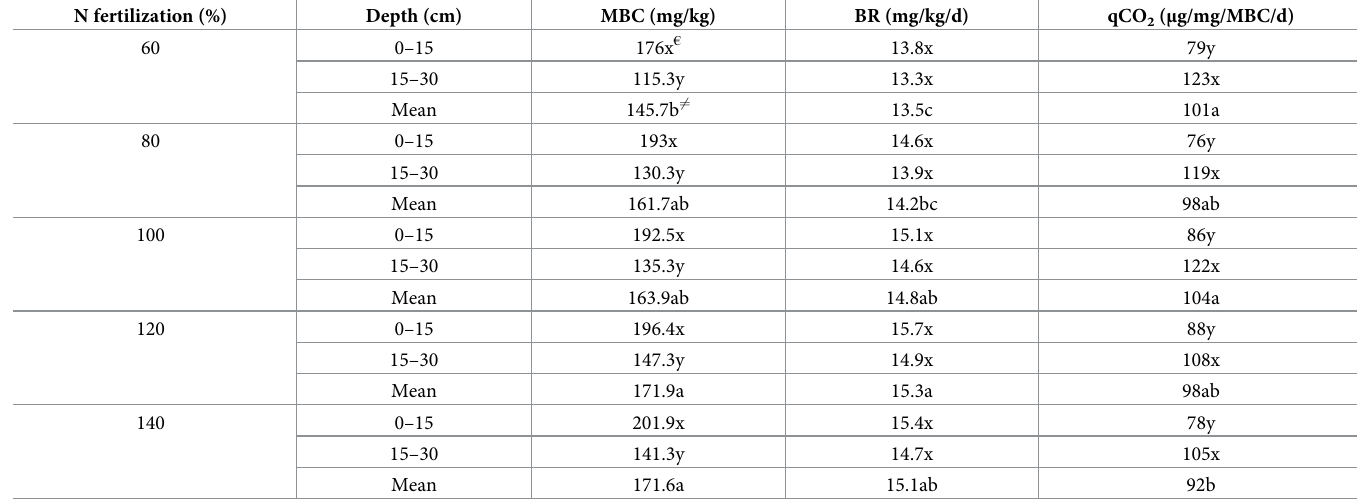
Table 1. Impact of nitrogen fertilization on soil depth distribution of microbial biomass, metabolic quotient, basal and specific maintenance respiration rates, and potentially mineralizable carbon concentration. N fertilization (%) Depth